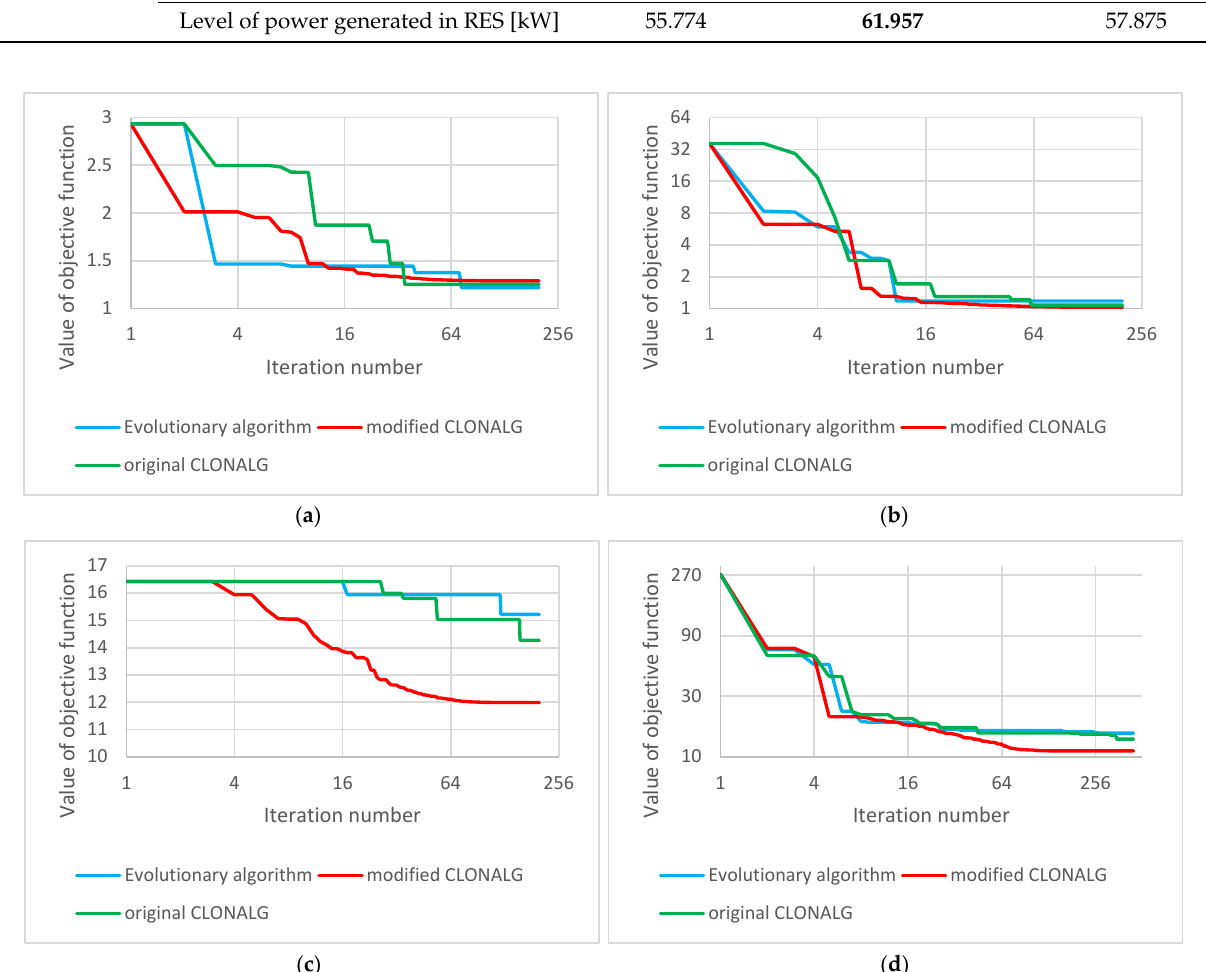
Figure 12. Convergence of optimization process for ( a ) task 1, synchronous operation; ( b ) task 1, island operation; ( c ) task 2, synchronous operation; ( d ) task 2, island operation 4.4. Discussion. Table 9. Comparison of results of the optimization calculations.